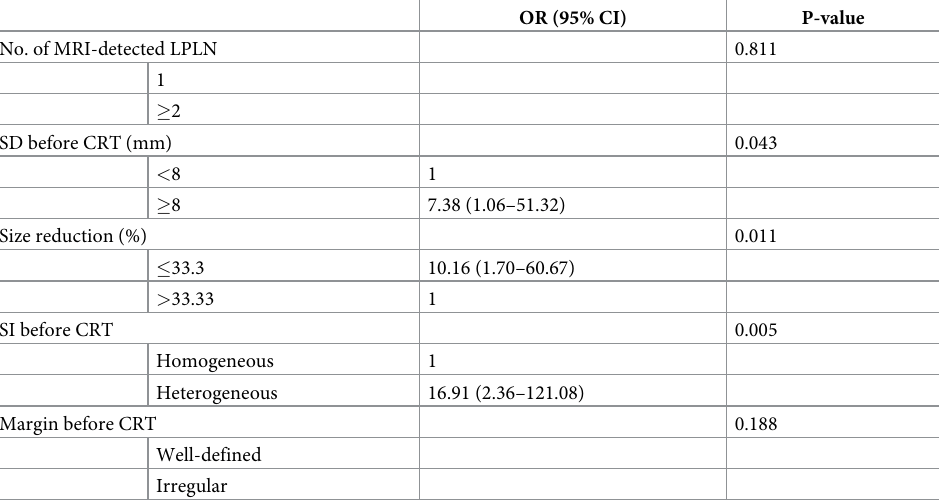
Table 3. The multivariable analysis using logistic regression